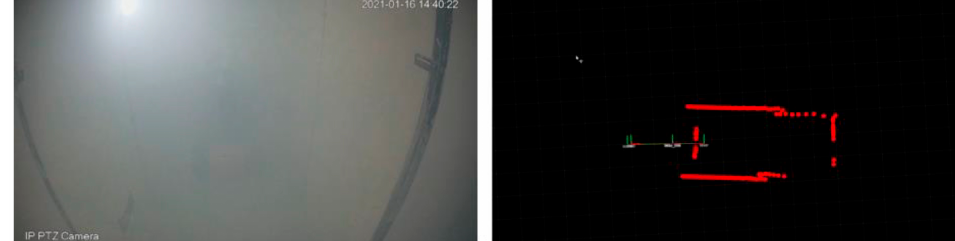
Figure 18. The laser point cloud of controlling the robot to move forward 1 m.